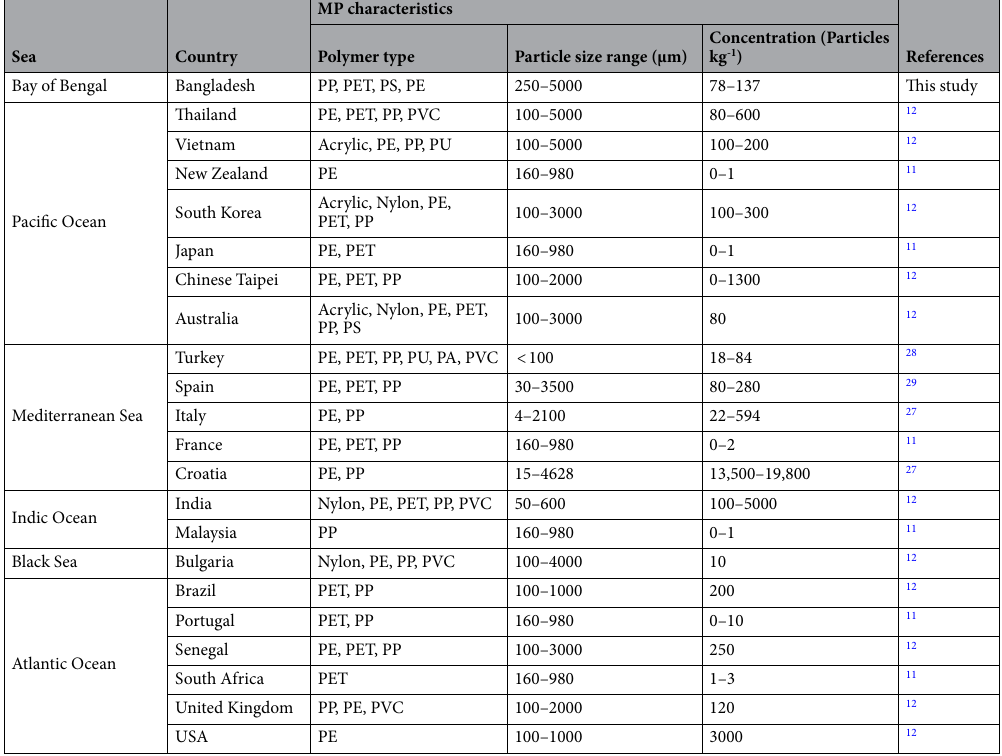
Table 2. Comparison of present and worldwide values for microplastics abundance, size range, and polymer types in commercial sea salt samples. PET Polyethylene terephthalate, PP Polypropylene, PE Polyethylene, PVC Polyvinyl chloride, PS Polystyrene, PA Polyamide, PU Polyurethane.